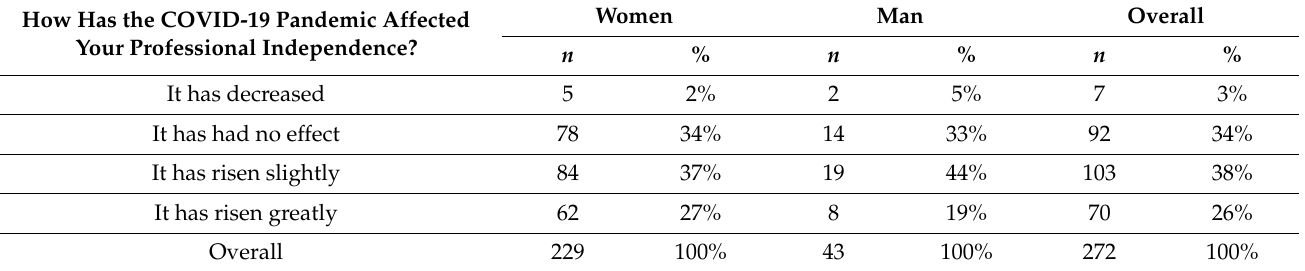
Table 6. The impact of the COVID-19 pandemic on independence in the group of women and men. How Has the COVID-19 Pandemic Affected